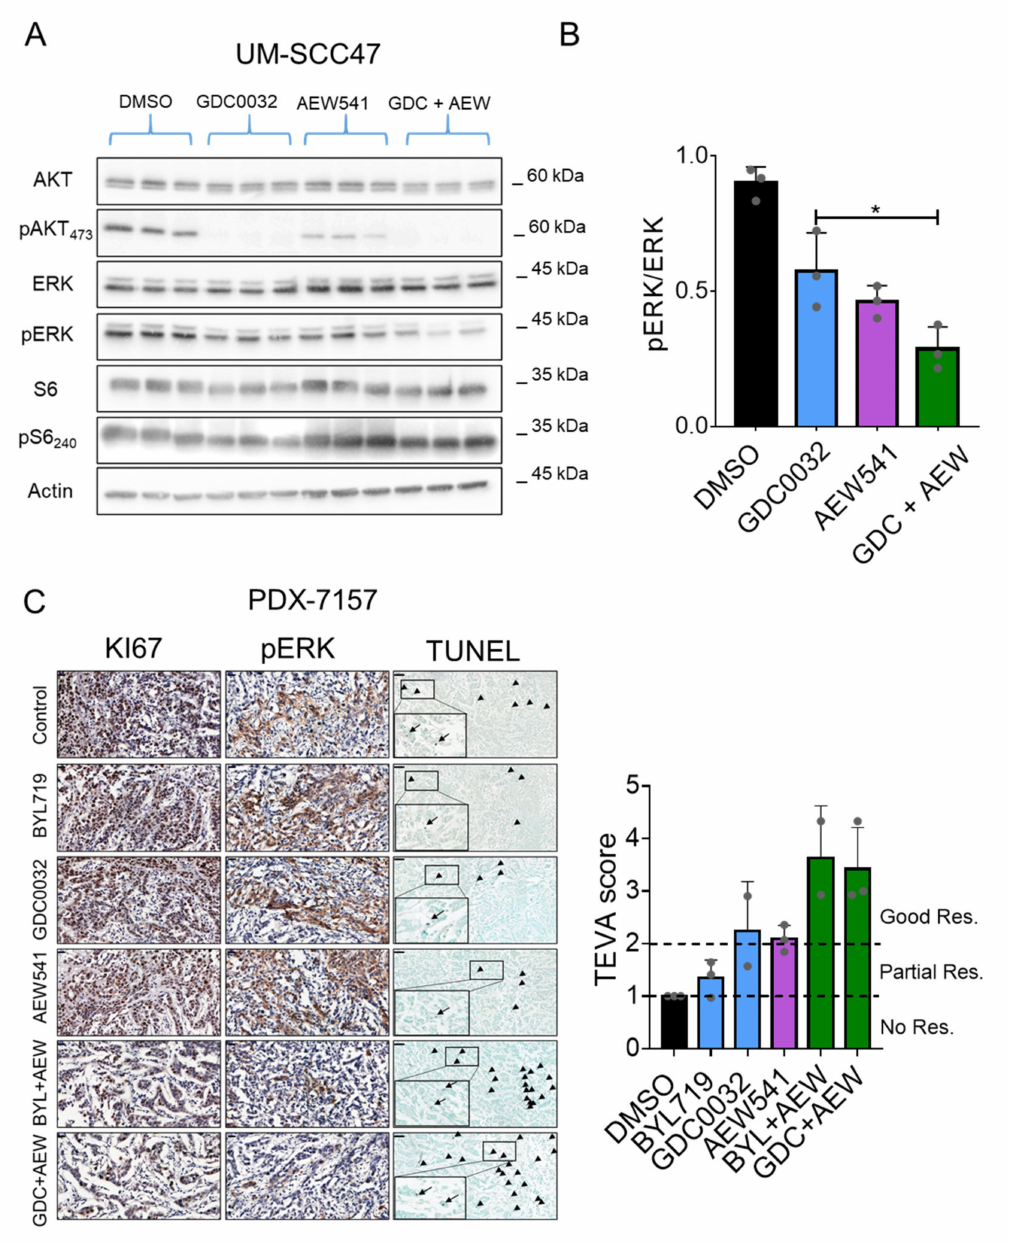
Figure 5. isiPI3K and AEW541 induced growth in a PDX HPV+ ex vivo model. ( A ) UM-SCC47 sensitive cells were treated for 4 h with DMSO, GDC0032 (500 nM), AEW541 (1 µ M), or a combination of the two drugs, after which cells were lysed. The indicated proteins and phosphorylated proteins were measured using western blot. ( B ) pERK plot was quantified with Adobe Photoshop 2020and normalized to ERK. The western blotting experiment was repeated 3 times, and representative results from one experiment are presented. ( C ) PDX HPV+ was cultured with DMSO, GDC0032 (500 nM) or BYL719 (2 µ M), AEW541 (1 µ M), or a combination of AEW541 with GDC0032 or BYL719, as indicated, for 24 h, after which the tissue was fixed and analyzed using IHC. Representative images of IHC staining for KI67, pERK, and TUNEL are presented together with the TEVA score. Scale bar for KI67 and MAPK: 20 µ m, for TUNEL: 50 µ m. Statistical significance was calculated by one-way ANOVA, * p <